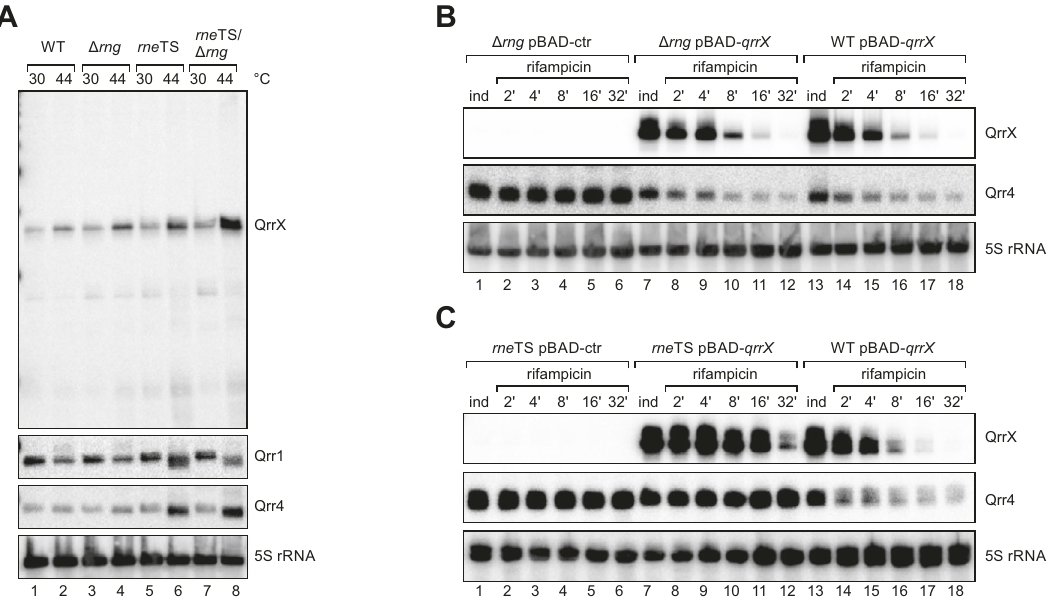
Fig. 4 | Role of ribonucleases in the QrrX - Qrr1-4 interactions. A In fl uence of RNase E and RNase G on QrrX levels. V. cholerae wild-type, Δ rng , RNase E tem- peraturesensitive( rne TS ),and Δ rngrne TS cellswerecultivatedat30°CtoOD600of 1.0,splitinhalfandeitherkeptat30°Corshiftedto44°Cfor60min.RNAsamples were collected and analyzed for QrrX, Qrr1, and Qrr4 levels by Northern blotting. 5S ribosomal RNA was used as loading control. The experiment was performed with three independent biological replicates ( n =3). B , C In fl uence of RNase E and RNase G on the stability of the QrrX-Qrr4 duplex. V. cholerae wild-type, Δ rng ( B )